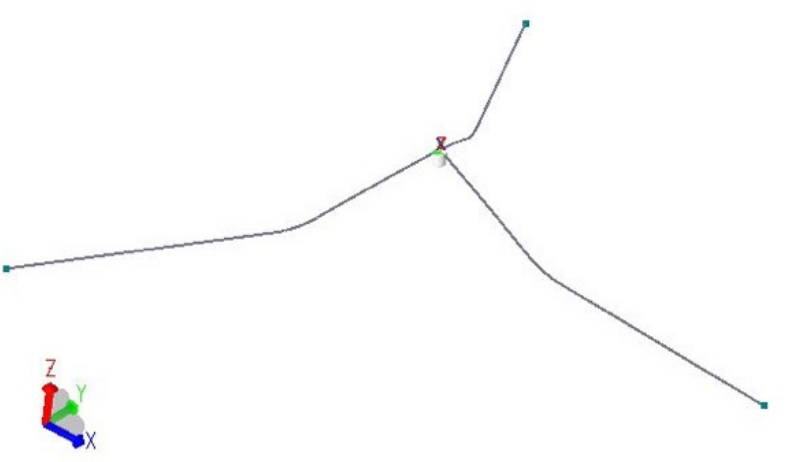
Figure 19. DeepC model, 3 components cable.